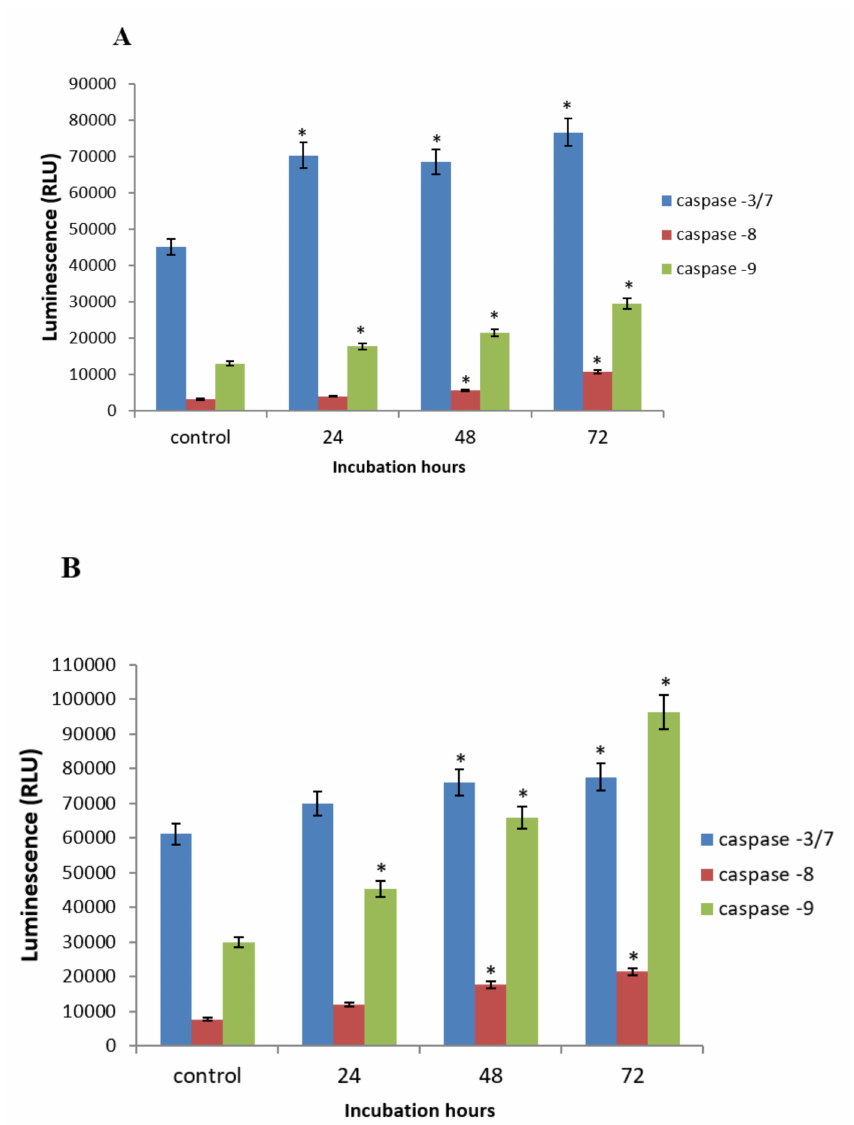
Figure 8. Modulation of caspase-3 / 7, -8, and -9 in HepG2 cells ( A ) and MCF-7 cells ( B ) treated with GNST-ITC at 7.83 µ M and 5.02 µ M, respectively for 24, 48, and 72 h measured using luminescence based-assay: Cells were cultured in serum free RPMI-1640 media and maintained at 37 ◦ C and 5% CO2. Values are presented as means ± SD of triplicate experiments. Significant di ff erence ( p < 0.05) as compared to control is indicated by